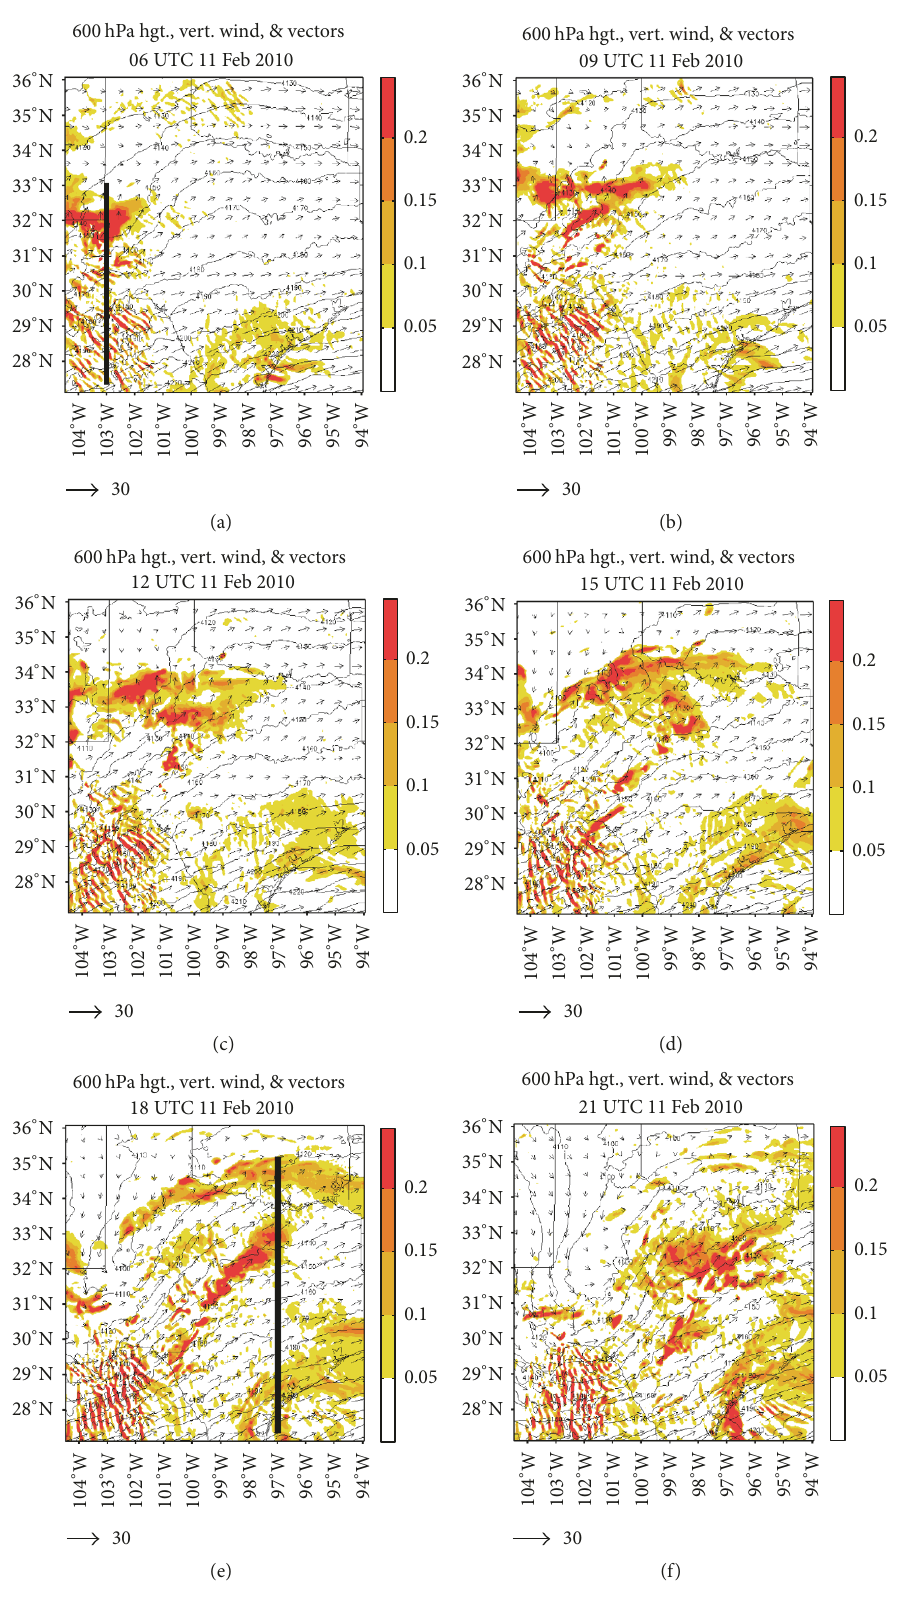
Figure 14: Simulated (4km) 600 hPa wind vectors, height in gpm, and upward vertical wind speed in m s −1 (shaded) on (a) 0600, (b) 0900, (c) 1200, (d) 1500, (e) 1800, and (f) 2100 UTC 11 February 2010. Black lines denote cross sections taken in Figure